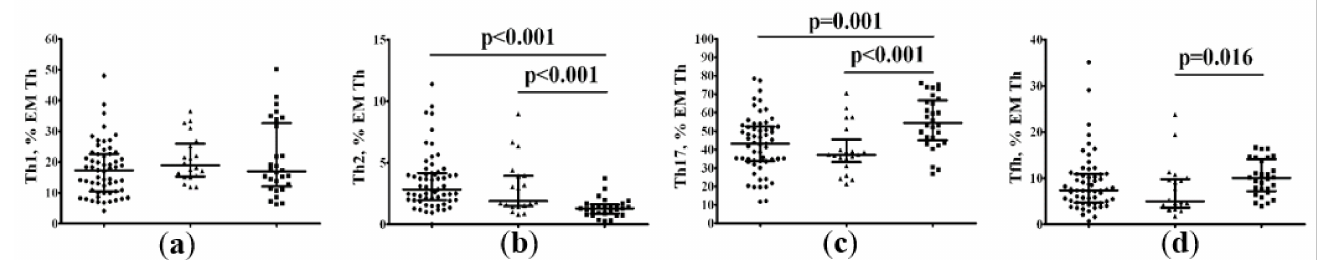
Figure 7. Imbalance of effector memory CD3+CD4+ Th cell subsets in patients with COVID-19. Scatter plots showing the relative count of the main “polarizes” Th cell subsets within the total central memory CD45RA − CD62L– Th cells, including Th1 (CXCR5-CXCR3+CCR6-CCR4-) ( a ), Th2 (CXCR5-CXCR3-CCR6-CCR4+) ( b ), total Th17 (CXCR5-CCR6+) ( c ), and CXCR5-positive Tfh cells ( d ), respectively, in peripheral blood samples from patients with 25(OH)D > 11.4 ng/mL (black circles), patients with 25(OH)D ≤ 11.4 ng/mL (black triangles), and HC subjects (black squares). Numbers represent the percentage of the indicated Th cell subset among the total lymphocyte